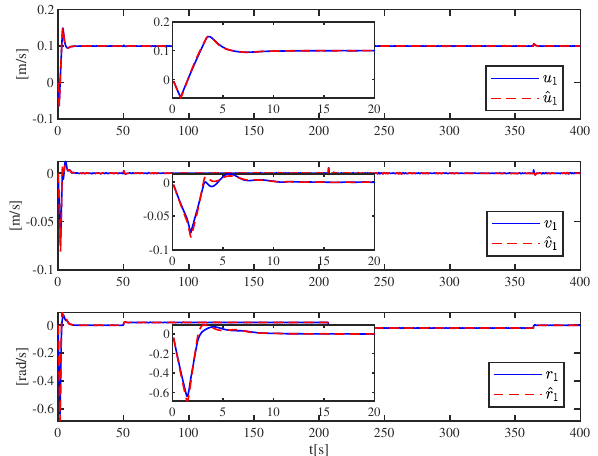
Figure 6. Control input of six USVs.